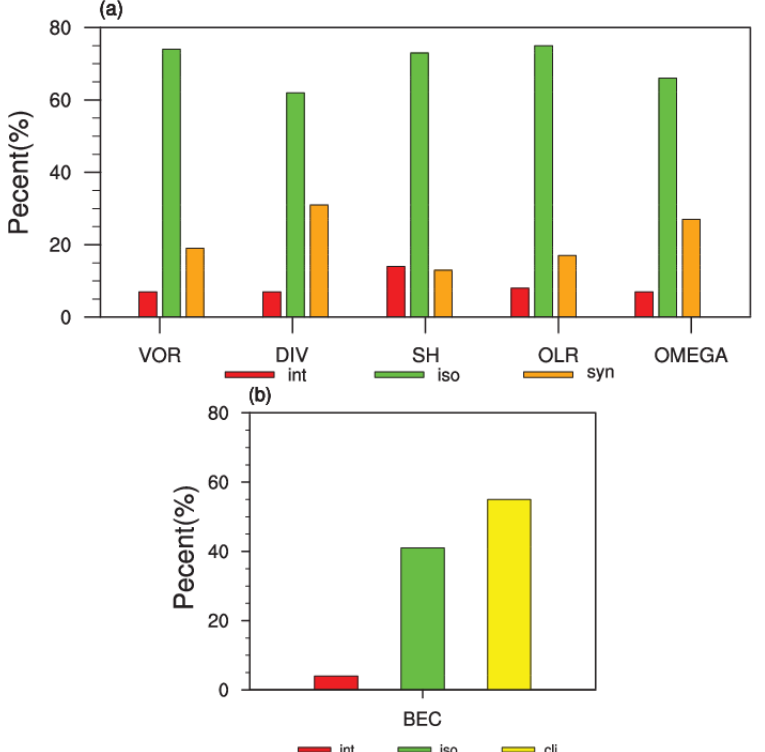
Figure 6. The percent (%) contributions ( a ) from anomalies of 850 hPa relative vorticity (VOR), 850 hPa divergence (DIV), 700 hPa specific humidity (SH), OLR, and 500 hPa vertical p-velocity (OMEGA) on interannual (red bar), intraseasonal (green bar), and synoptic (orange bar) time scales; and ( b ) 850 hPa barotropic energy conversion (BEC) with regard to interannual (red bar), intrasea-